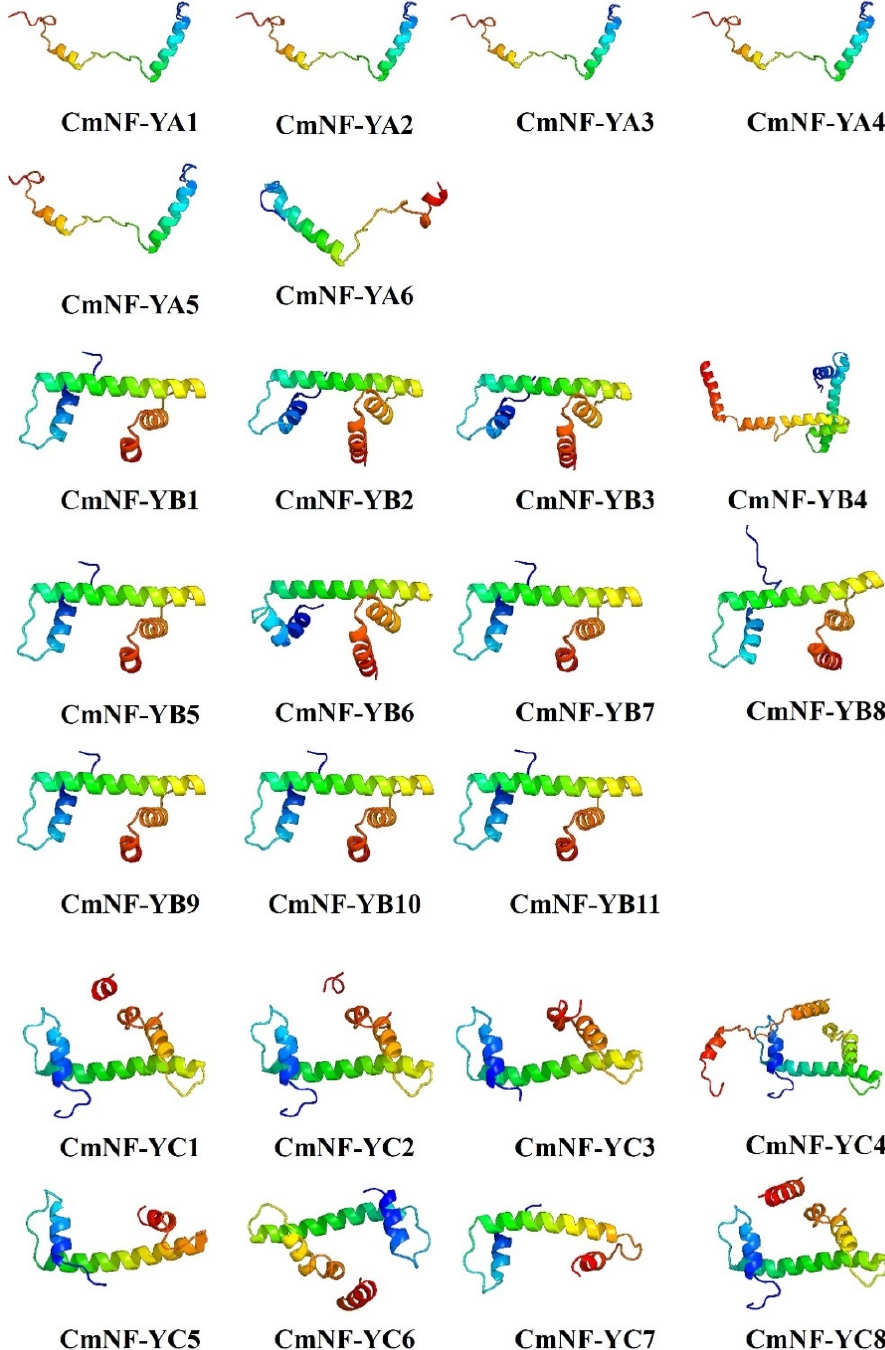
Figure 4. Tertiary structure of CmNF-Ys predicted by homologous modeling.